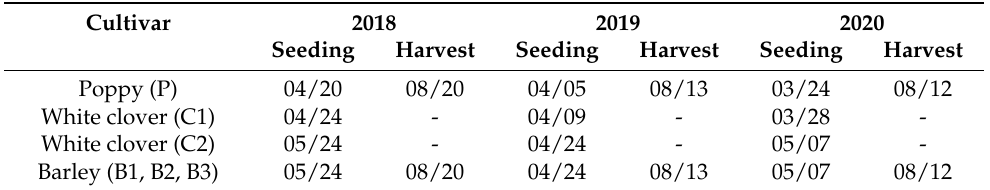
Table 4. The seeding dates of poppy, clover and barley in the intercrop experiment 2018–2020 at Campus Klein-Altendorf,